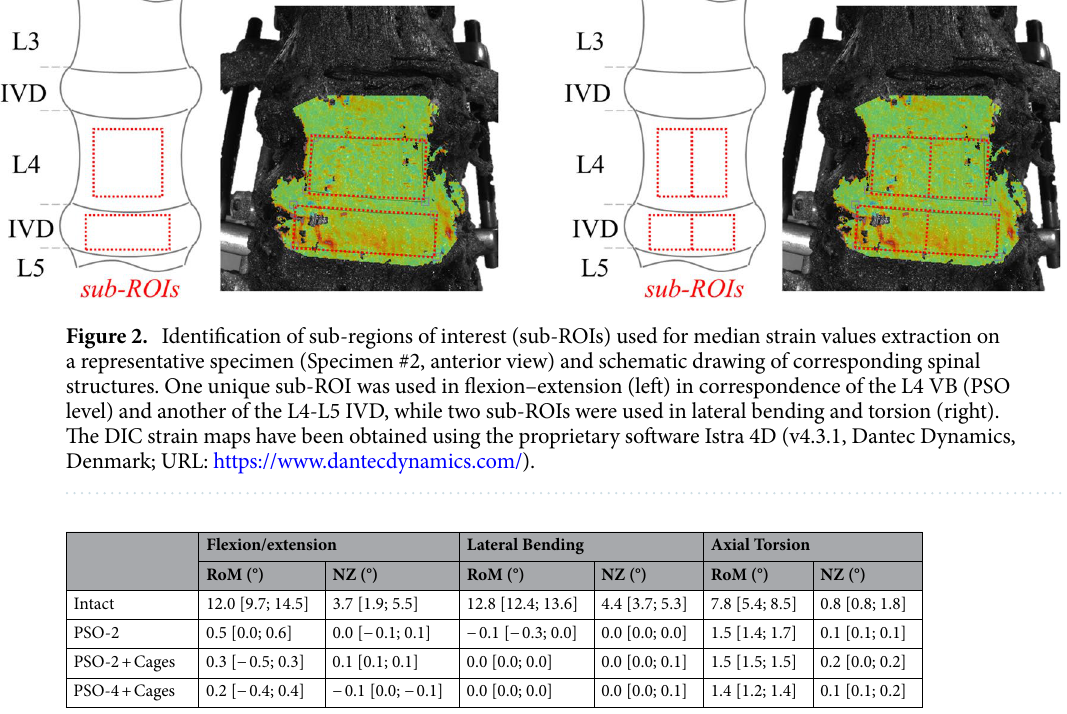
Table 2. Median [min; max] local (L3–L5) range of motion (RoM) and neutral zone (NZ) values for each instrumentation step. Data for each specimen provided as Supplementary Table